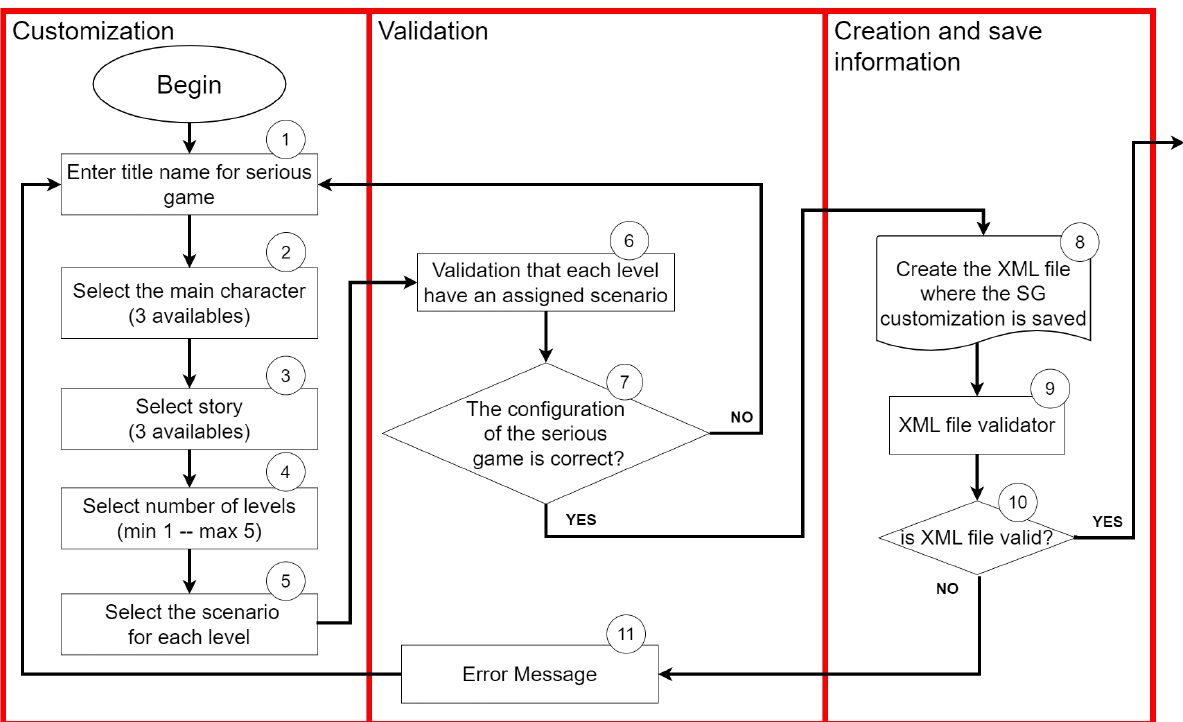
Figure 1. The first part of the flowchart is where SG setup